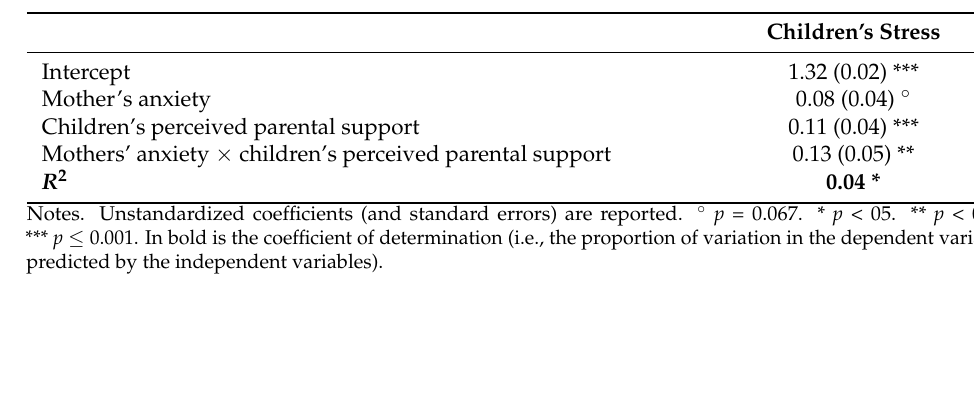
Table 2. Regression analysis predicting children’s